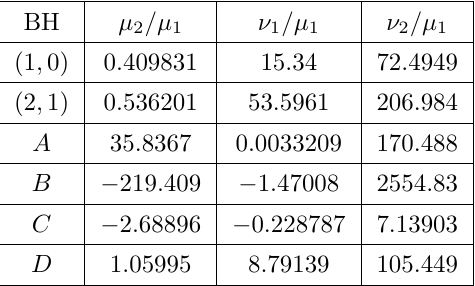
Table 4. The ratios of µ i , ν i parameters for the six BPS black holes considered in this paper; these values are those obtained in the extremal limit m → 0 , thus are those of the static, BPS black hole.